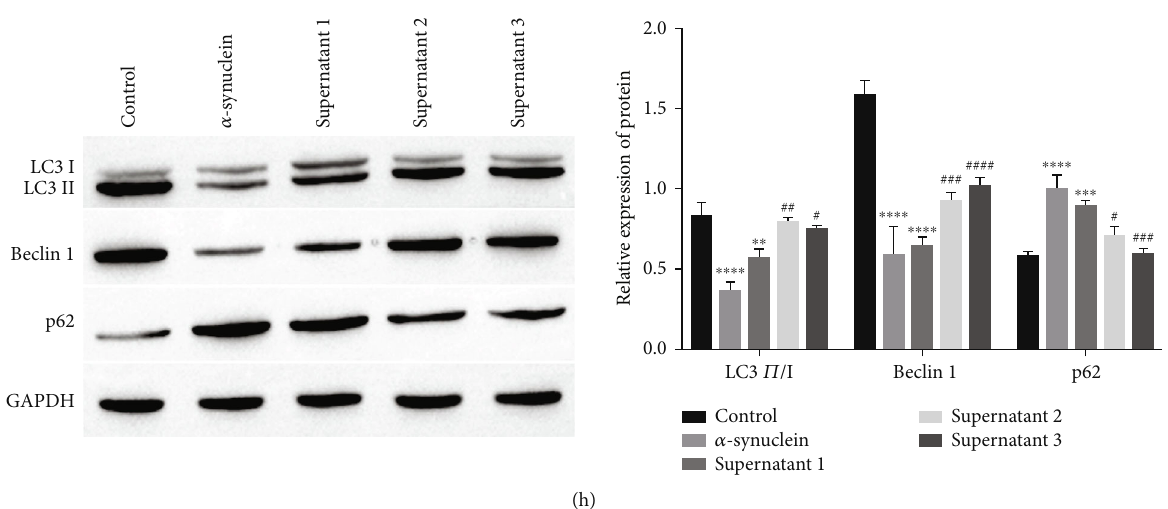
Figure 4: E ff ect of α -synuclein on autophagy and the in fl ammatory response of microglia. (a) The expression of α -synuclein in BV-2 cells was detected by immuno fl uorescence. Scale bar = 100 px. (b) The level of MIP-1 α was detected by ELISA, ∗∗∗∗ P < 0 : 0001 vs. control and #### P < 0 : 0001 vs. supernatant 1. (c) The level of TNF- α was detected by ELISA, ∗∗∗∗ P < 0 : 0001 vs. control and #### P < 0 : 0001 vs. supernatant 1. (d) The level of IL-6 was detected by ELISA, ∗∗∗∗ P < 0 : 0001 vs. control and #### P < 0 : 0001 vs. supernatant 1. (e) The level of TNF- α was detected by ELISA, ∗∗∗∗ P < 0 : 0001 vs. control and #### P < 0 : 0001 vs. supernatant 1. (f) The level of INF- γ was detected by ELISA, ∗∗∗∗ P < 0 : 0001 vs. control and #### P < 0 : 0001 vs. supernatant 1. (g) NF- κ B p65 nuclear translocation assay, scale bar = 100 px. (h) The expressions of LC3 II/I, Beclin 1, and p62 were detected by western blot, ∗∗ P < 0 : 01 , ∗∗∗ P < 0 : 001 , and ∗∗∗∗ P < 0 : 0001 vs. control and # P < 0 : 05 , ## P < 0 : 01 , ### P < 0 : 001 , and #### P < 0 : 0001 vs. supernatant 1 (note: supernatant 1 group: the supernatant of MN9D cells overexpressing MALAT1 was cocultured with BV2 cells; supernatant 2 group: the supernatant of MN9D cells cotransfected with pcDNA-MALAT1+miR-23b-3p mimic was cocultured with BV2; supernatant 3 groups: the supernatant of MN9D cells cotransfected with pcDNA-MALAT1+sh- α -synuclein was cocultured with